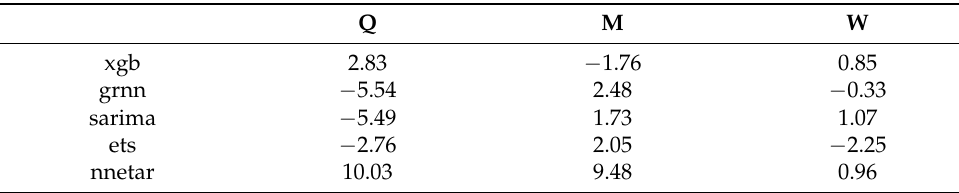
Table 5. Relative errors of forecasts in percent.